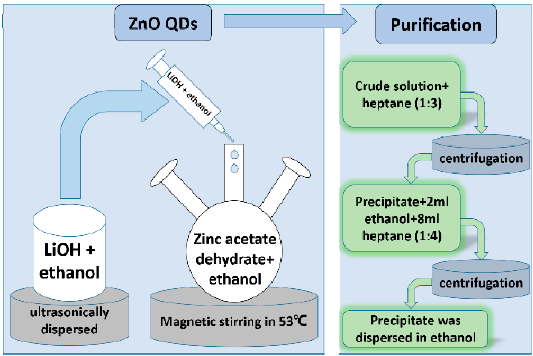
Figure 2. Preparation steps of ZnO QDs.